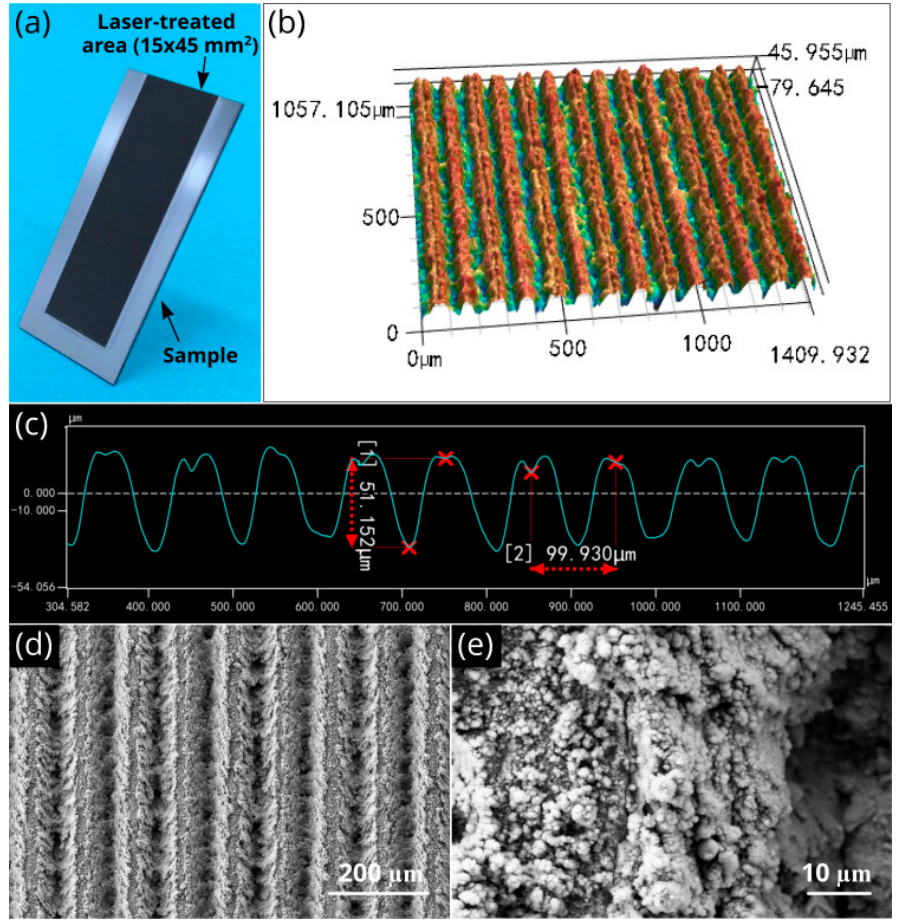
Figure 2. ( a ) Photograph of the wicking silicon sample. ( b ) 3D optical image of the array of parallel microgrooves. ( c ) Microgroove profile. ( d ) Scanning electron microscope (SEM) image of parallel microgrooves. ( e ) Nano- and micro-structural features of a microgroove.